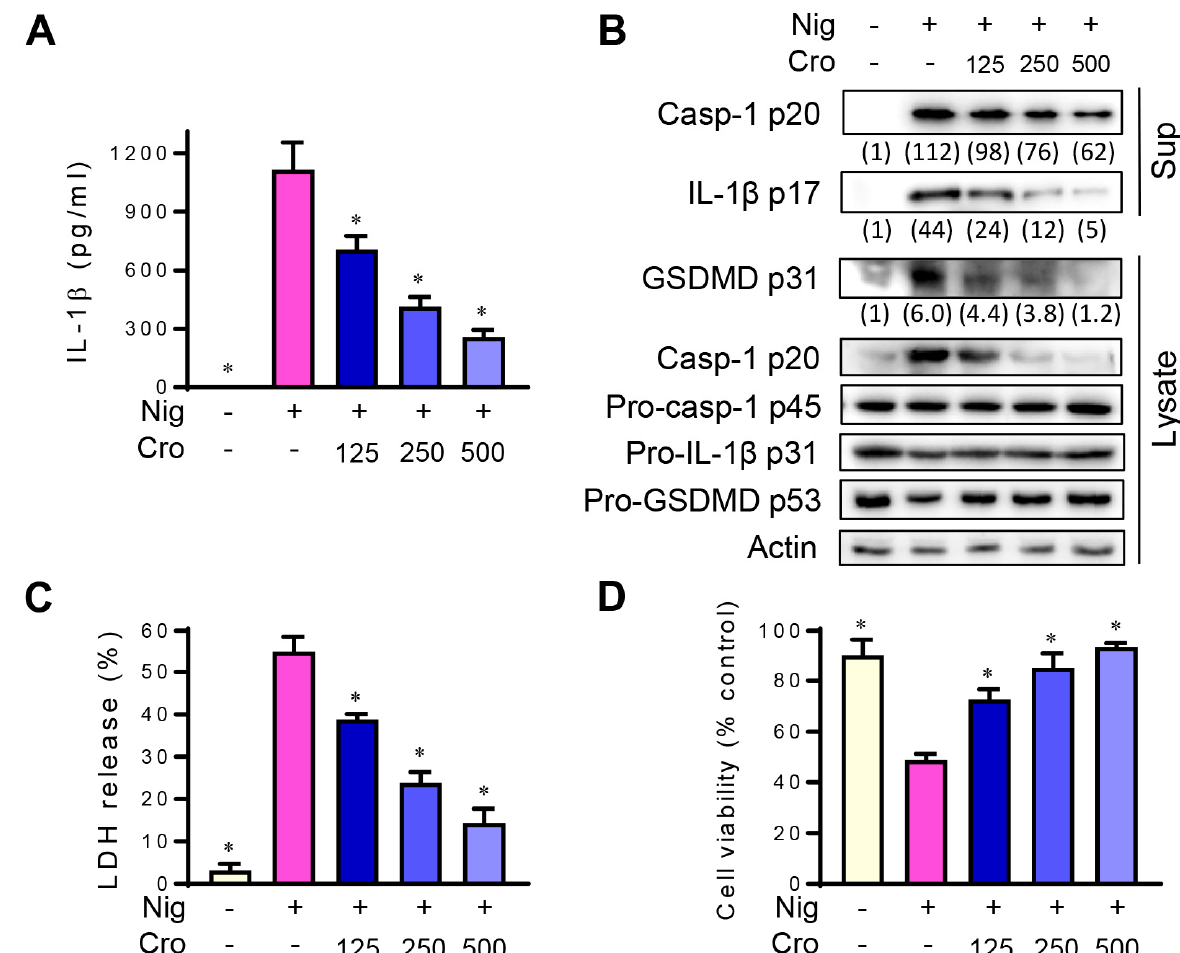
Figure 3. Inhibitory effects of Crocin on NLRP3 inflammasome in mouse peritoneal macrophages. LPS-primed mouse peritoneal macrophages were pretreated with various concentrations of Crocin (Cro, µ M) for 3 h, and then incubated with Nigericin (4 µ M) for 1 h. ( A ) IL-1 β in the cell culture supernatant was measured by ELISA. ( B ) Cleaved caspase-1 p20 and IL-1 β p17 in the cell culture supernatant and GSDMD, pro-caspase-1 and pro-IL-1 β in cytosolic extract were detected by Western blot. Relative intensity of caspase-1 p20, IL-1 β p17, and cleaved GSDMD was quantified using image analysis software, ImageJ (http://rsb.info.nih.gov/ij, accessed on 28 February 2023). LDH re- lease ( C ) and Cell viability ( D ) were assayed as described in Figure 2. The data are expressed as the mean ± SEM and represent three experiments. * p < 0.05 vs. the group treated with Nigericin. To check whether Crocin inhibits other inflammasomes, such as NLRP1 or AIM2, treatments were performed using MDP (an NLRP1 inflammasome trigger) and